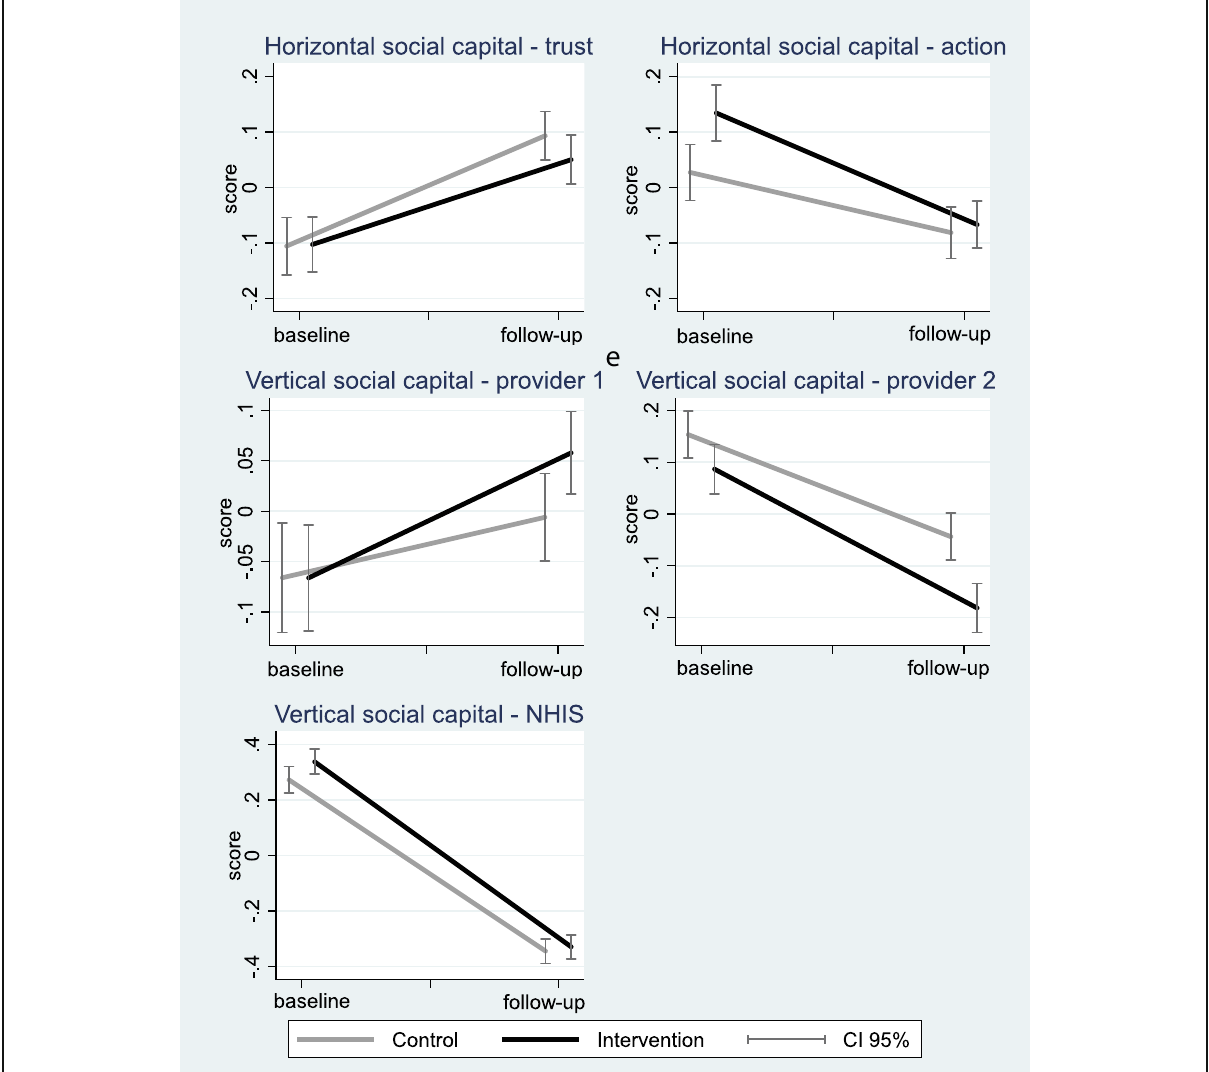
Fig. 4 Changes in the five social capital factors from baseline to follow-up. Notes: The levels (scores) of social capital are estimated from 16 survey items with principal component analysis explained in Section “ Respondents and measures ” and Additional file